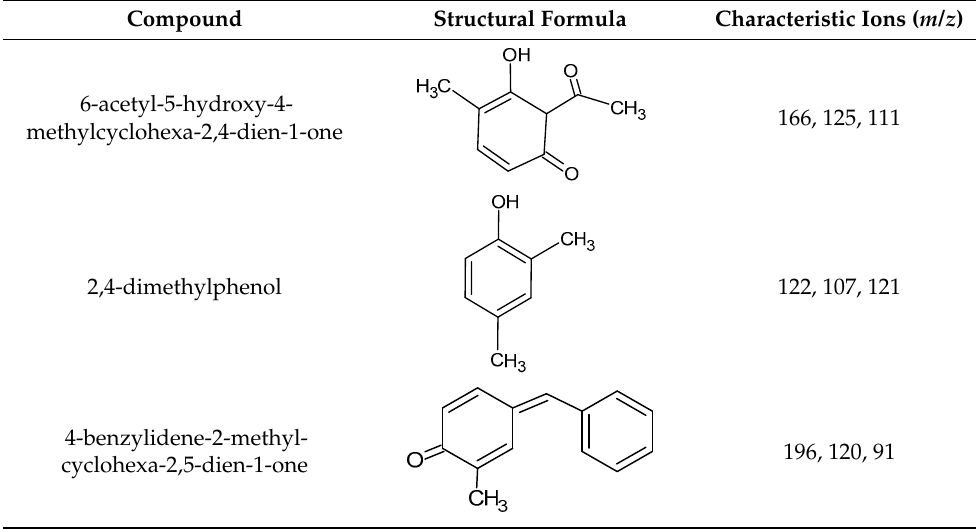
Table 3. Products obtained during electrochemical degradation, identified by GC-MS analysis. Compound Structural Formula